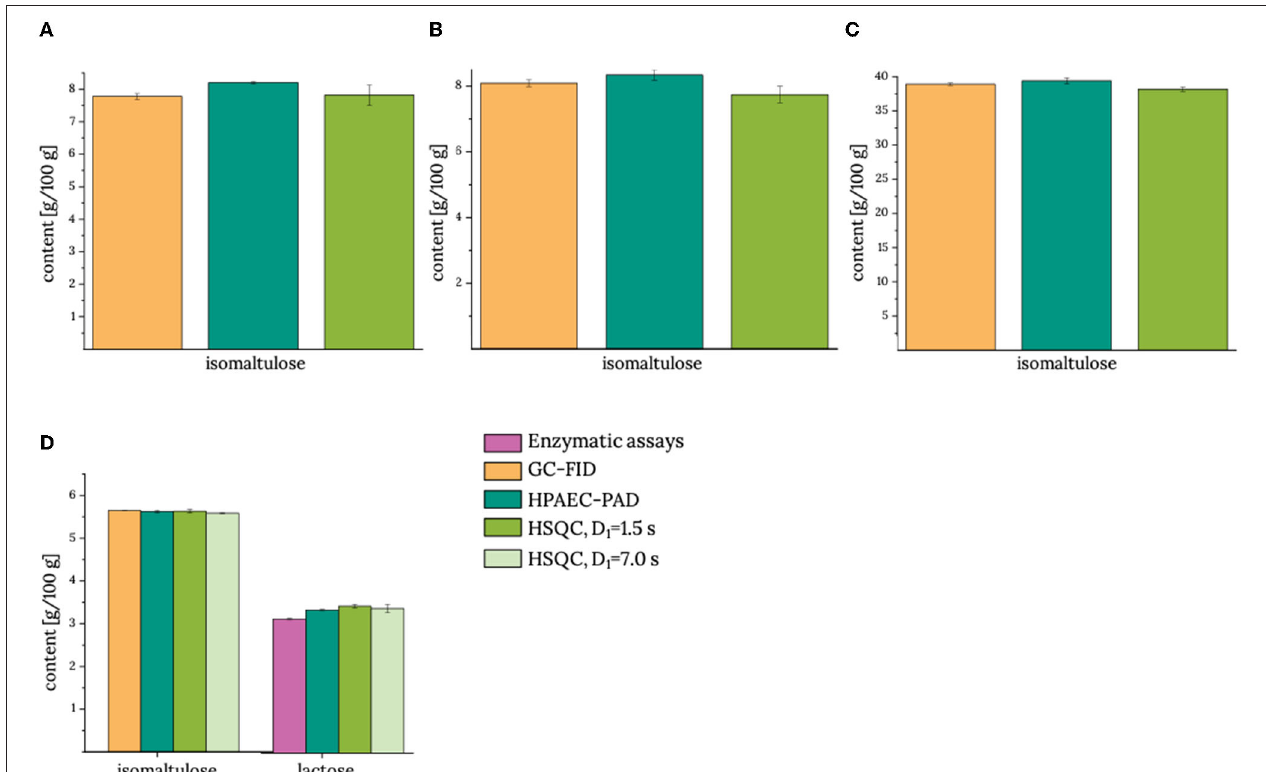
FIGURE 3 | Contents of isomaltulose and (if applicable) lactose in (A) product 4 , (B) product 5 , (C) product 7 , and (D) product 6 . GC-FID: gas chromatography with flame ionization detector; HPAEC-PAD: high-performance anion-exchange chromatography with pulsed amperometric detection; HSQC, heteronuclear single quantum coherence; D 1 , interscan delay. Analyses by using the reference methods were performed in duplicate using the half range to demonstrate the spread of the data. HSQC measurements were performed in triplicate determination, and the standard deviation is given. Actual data are given in Supplementary Table S2 .